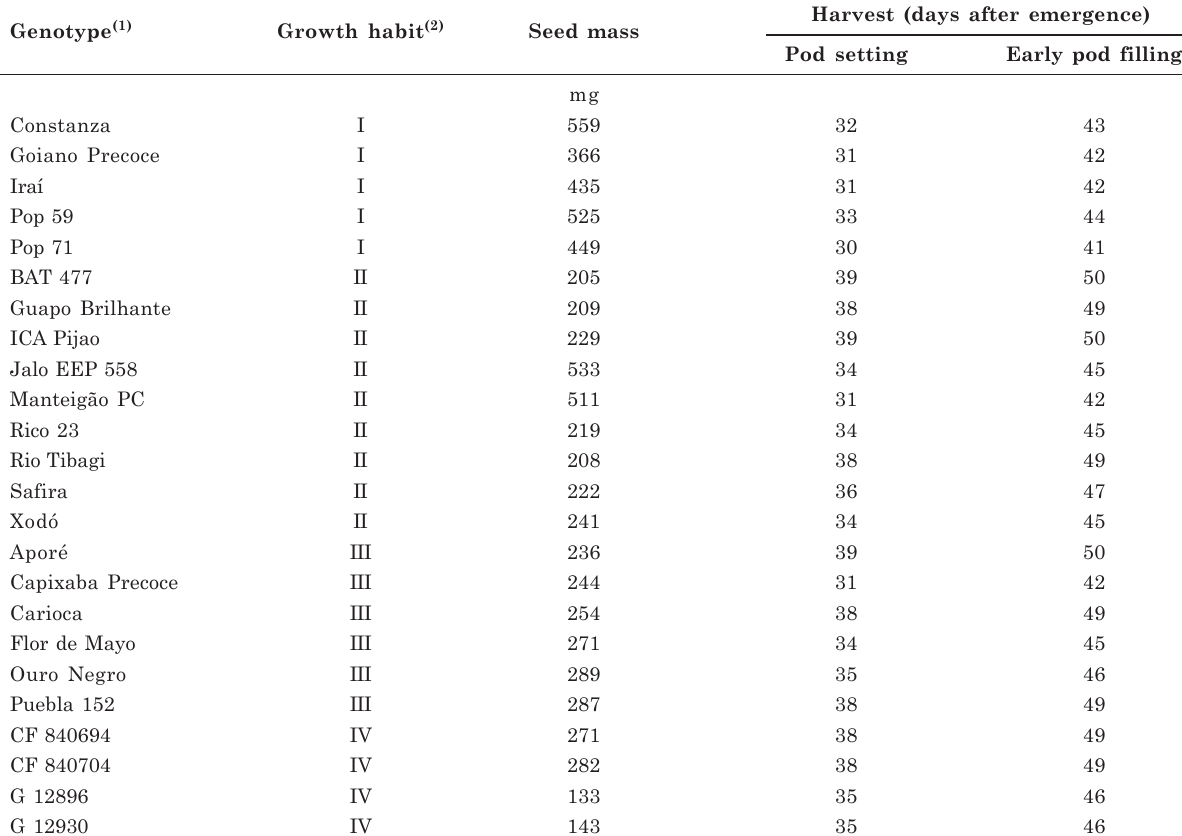
Table 1. Some characteristics of the 24 genotypes of common bean ( Phaseolus vulgaris )